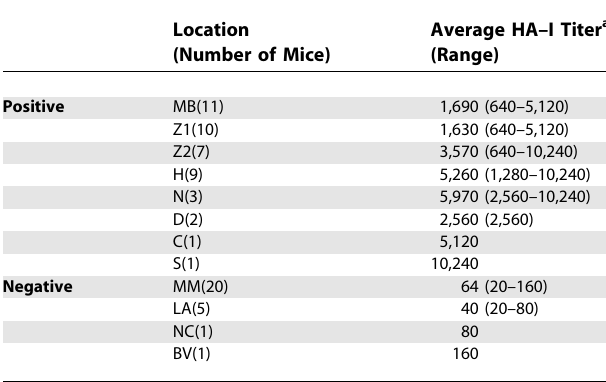
Table 2. Serological Tests for Py Virus in Feral Mice Location (Number of